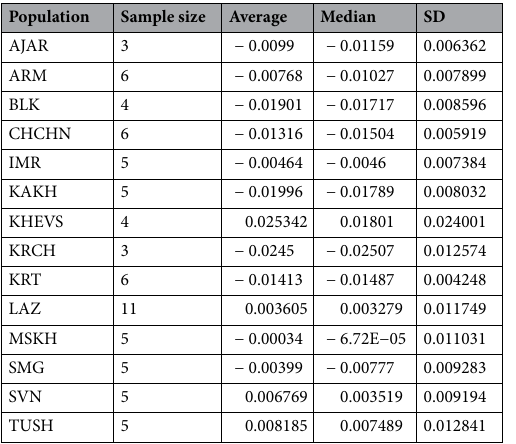
Table 4. Statistics of excess homozygosity-based inbreeding estimate (“fhat2” estimate of PLINK 1.9).